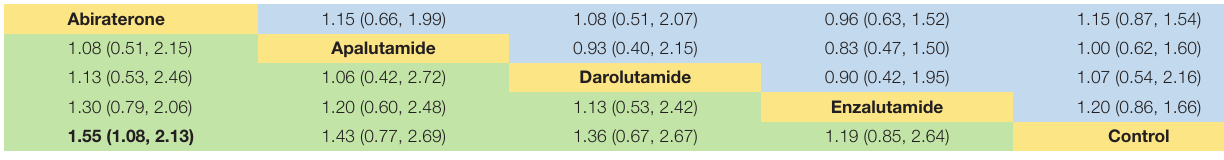
TABLE 4 | Network meta-analysis for RR of diarrhea (below diagonal) and constipation (above diagonal).